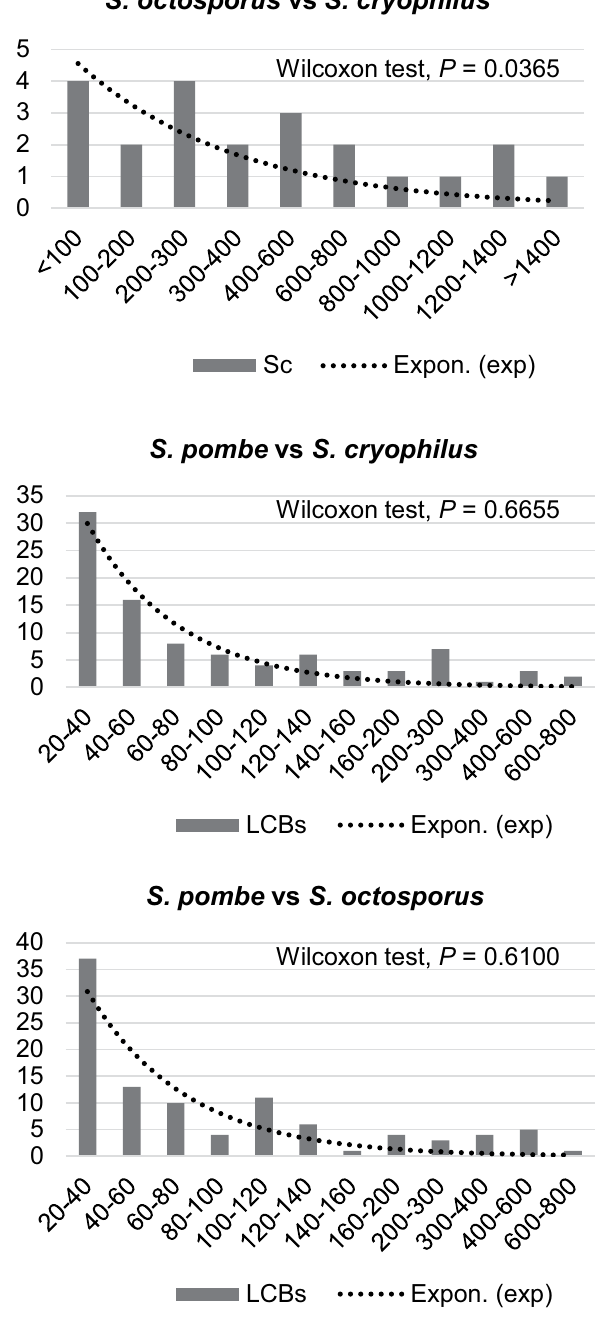
Figure 5. Comparison of histograms of LCBs’ lengths to random breakage model of chromosomal evolution (dashed lines). According to random breakage model distances between breakpoints should follow an exponential distribution of the form f(x) = 1/L e − x/L, where L is the average size of all syntenic segments. Numbers on the horizontal axes indicate the distribution of the lengths of LCBs in Kb. Values of the vertical axes show the frequency of LCBs at a given length. Analysis of S. octosporus – S. cryophilus proved that the concerning values did not show agreement with the random breakage model. However, values of S. pombe – S. cryophilus and of S. pombe – S. octosporus did not diverge largely from the model